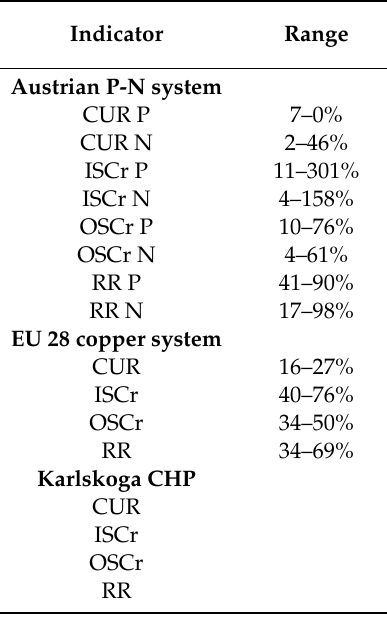
Table 1. Range under all potential and under commonly made assumptions as well as results for the assumptions made in the present analysis for the circularity indicators cyclical use rate (CUR), input socioeconomic cycling rate (ISCr), output socioeconomic cycling rate (OSCr), and recycling rate (RR). Indicator definitions according to Equations (1)–(4).